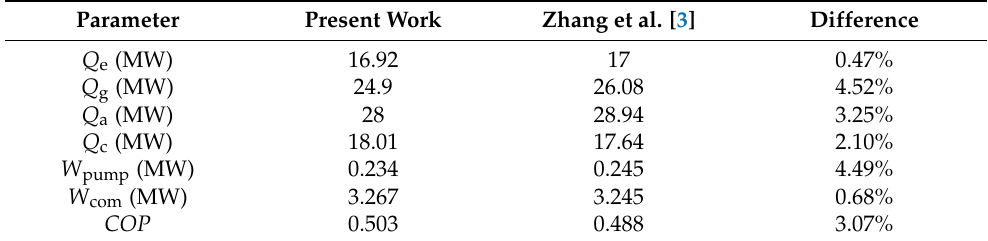
Table 5. Comparison of simulation results for two-stage cycle with thermal and mechanical compres- sion processes.